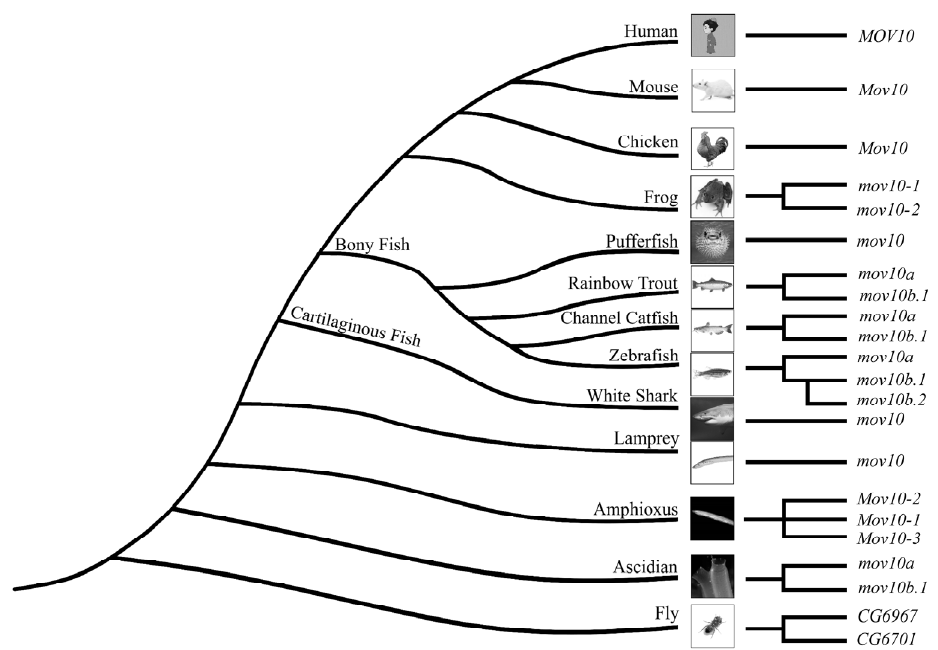
Figure 10. The lineage-specific intra-chromosomally duplications and tandem duplication of mov10 occurred among species.